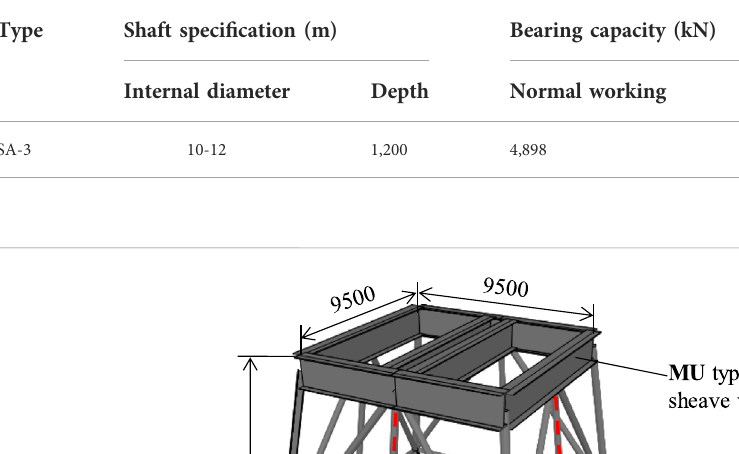
TABLE 1 Main parameters of the SA-3 shaft sinking headframe.